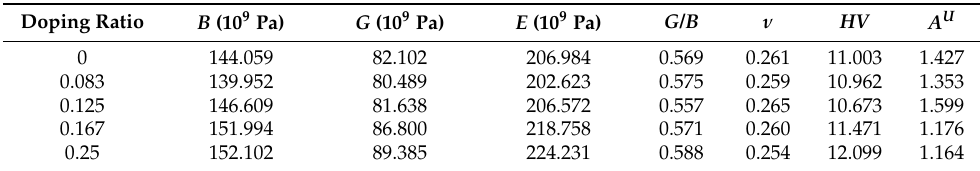
Table 5. Bulk modulus ( B ), shear modulus ( G ), Young’s modulus ( E ), Poisson’s ratio ( ν ), Hardness ( HV ), and universal elastic anisotropy index ( A U ) of various SnO 2